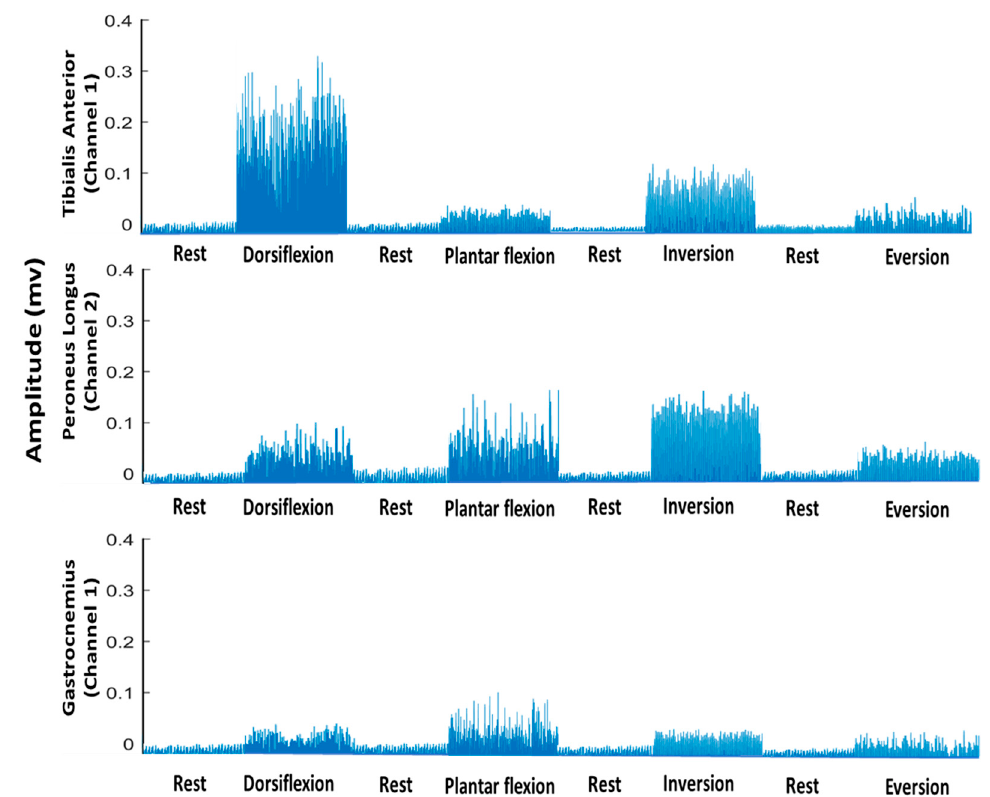
Figure 2. Rectified and bandpass-filtered EMG signal (only for understanding and visualization) of all motion classes and all channels separately for subject 3.